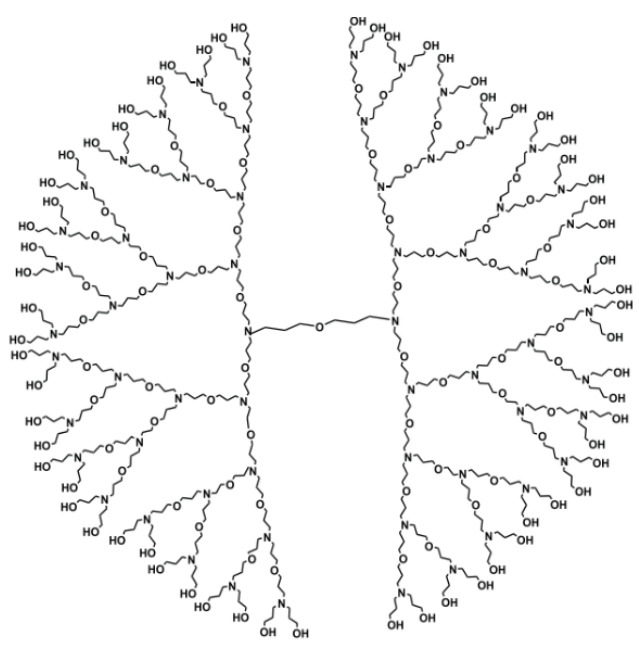
Figure 3. D 3 ( n ) with n =